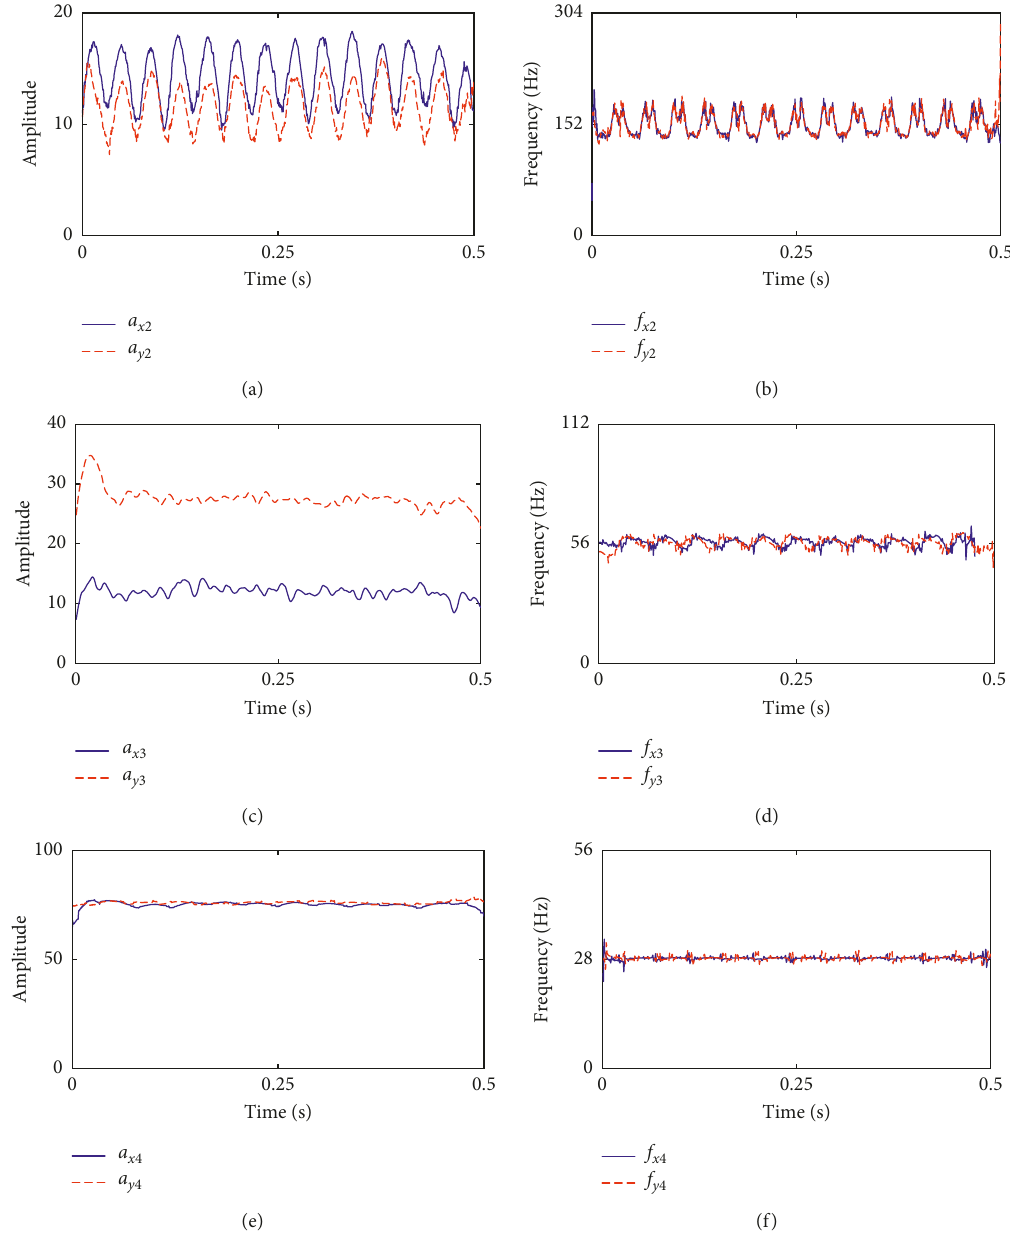
Figure 21: The instantaneous amplitude and frequency of c 2 , c 3 , and c 4 obtained by the HT: (a) the instantaneous amplitude of the real part and imaginary part of c 2 ; (b) the instantaneous frequency of the real part and imaginary part of c 2 ; (c) the instantaneous amplitude of the real part and imaginary part of c 3 ; (d) the instantaneous frequency of the real part and imaginary part of c 3 ; (e) the instantaneous amplitude of the real part and imaginary part of c 4 ; (f) the instantaneous frequency of the real part and imaginary part of c 4